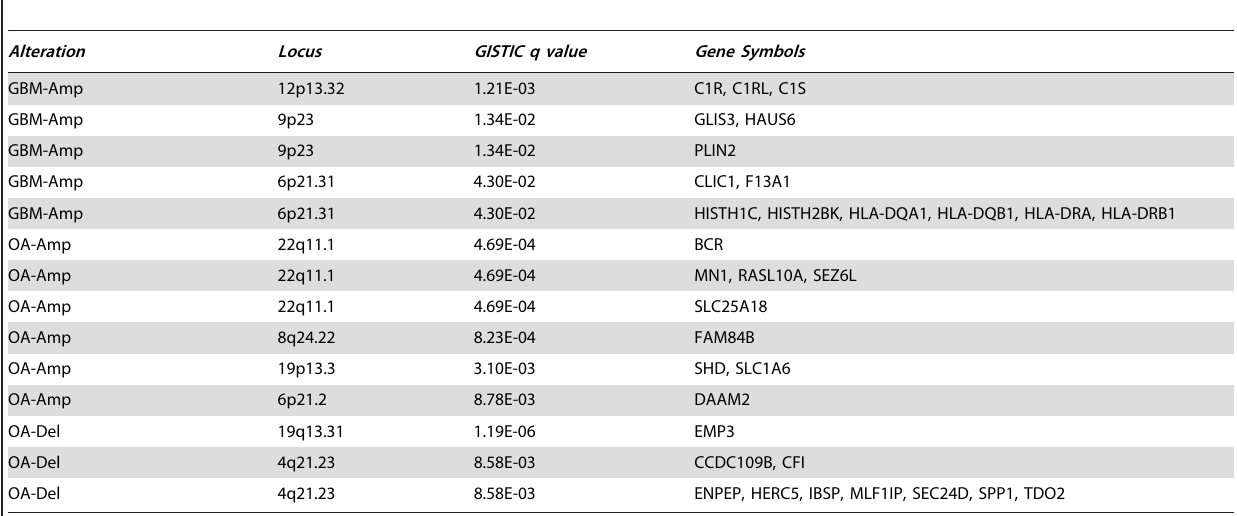
Table 4. Integrated analysis of differences in gene expression and copy number between Proneural GBM and Proneural Oligodendroglioma/Astrocytoma samples.